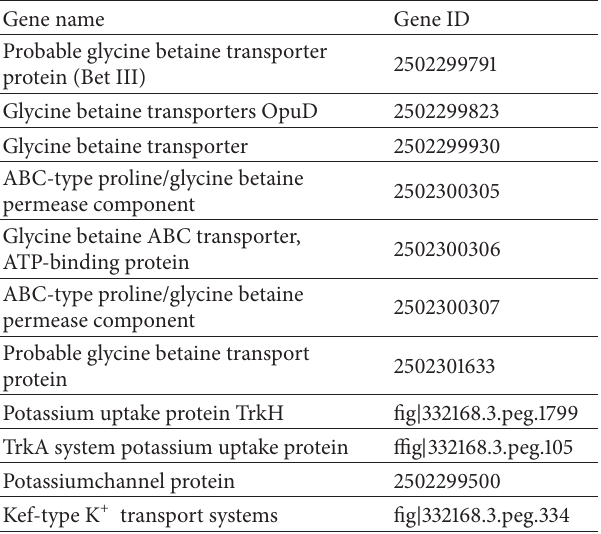
Table 2: Putative osmoadaptive genes identified in H. hamelinensis genome.